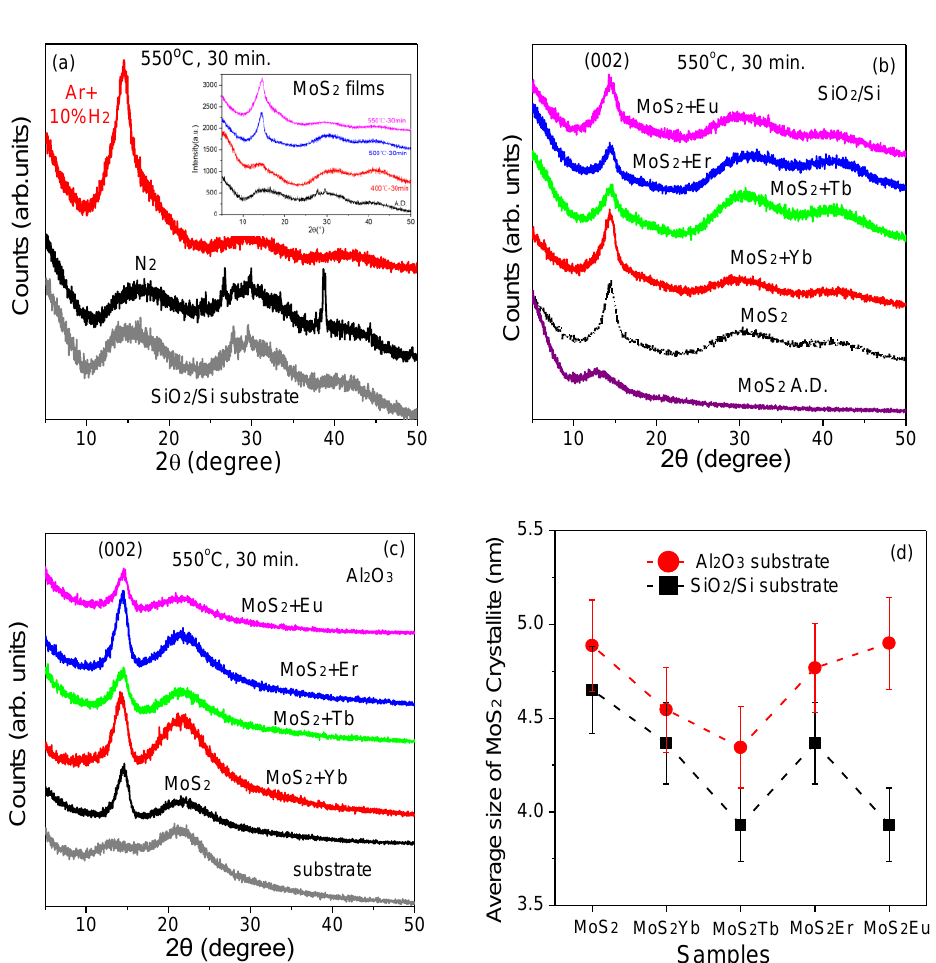
Figure 1. ( a ) The XRD spectra of the MoS 2 samples deposited on SiO 2 /Si substrate after annealing at 550 ◦ C for 30 min in N 2 and Ar + 10% H 2 ambience. ( b , c ) The XRD spectra of the RE-doped MoS 2 samples deposited on the SiO 2 /Si substrate or the Al 2 O 3 substrate and then annealed at 550 ◦ C for 30 min in Ar + 10% H 2 ambience. ( d ) A comparison of the average size of MoS 2 nanoparticles in the samples.